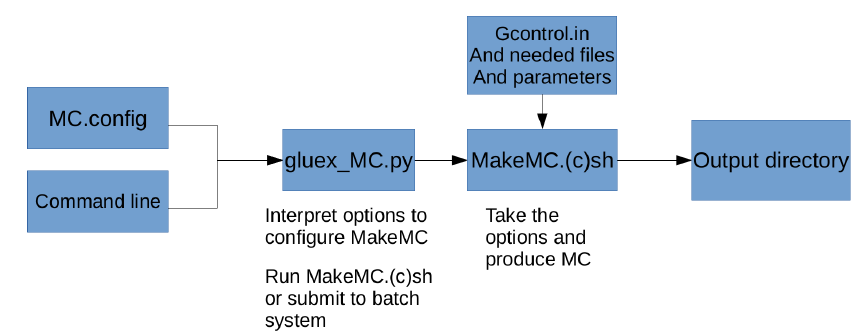
Figure 1. The basic structure of MCwrapper’s underlying system. Parameters from MC.config and the command line are fed to gluex_MC which breaks the request into the necessary jobs, configuring